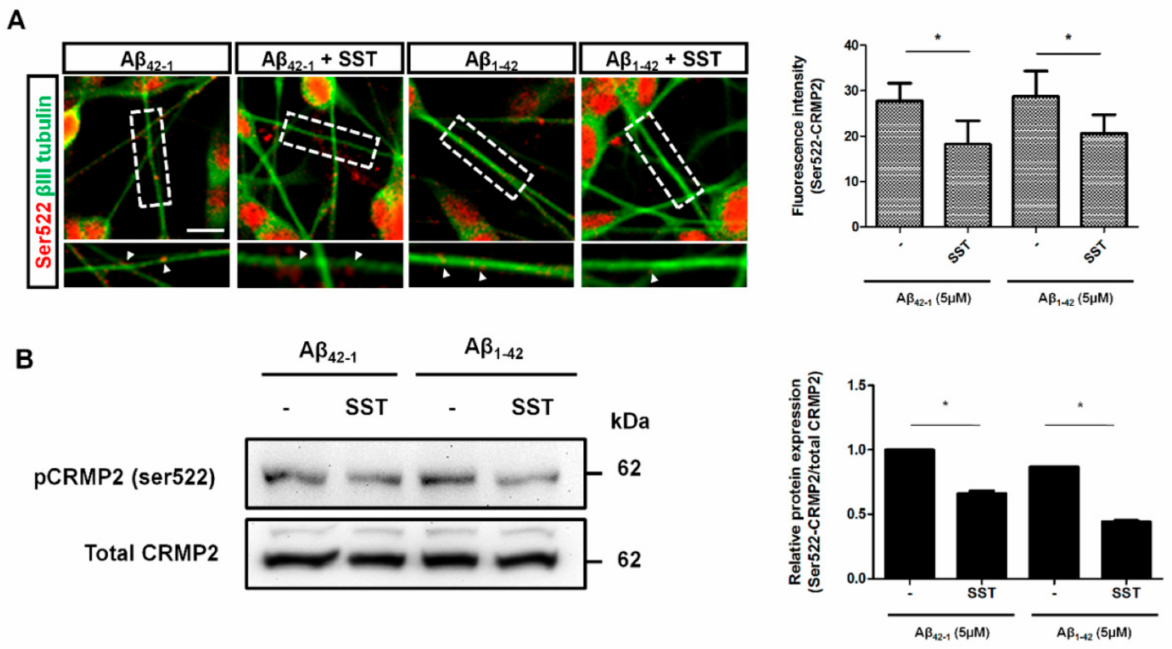
Figure 4. SST inhibits S522-CRMP2 phosphorylation. ( A ). Immunofluorescence staining image of Ser522-CRMP2 (red) co-stained with neuronal tubulin marker β III-tubulin (green). The colocalization of Ser522-CRMP2 on neurites with β III-tubulin is indicated (arrowhead; inset), and the average fluorescence intensity of S522-CRMP2 (in red) is shown on the bar graph. ( B ). Representative Western blot showing reduced phosphorylation at Ser522-CRMP2 in the presence of SST (bottom panel). The densitometry analysis of the Western blot is corroborated with a significant reduction in the phosphorylation level in the presence of SST in both A β 42-1 and A β 1-42 treated cells (upper panel). The data represent the mean ± SD of three independent experiments. * p < 0.05 against respective control; Scale bar = 20 µ